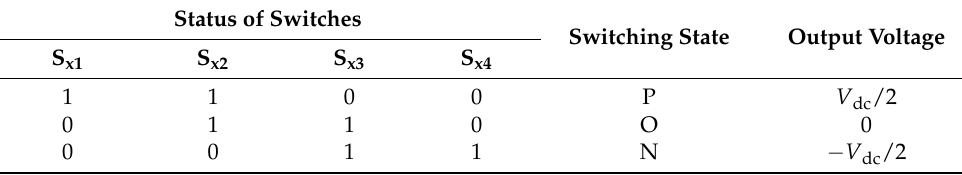
Table 1. The definition of switching state for NPC three-level